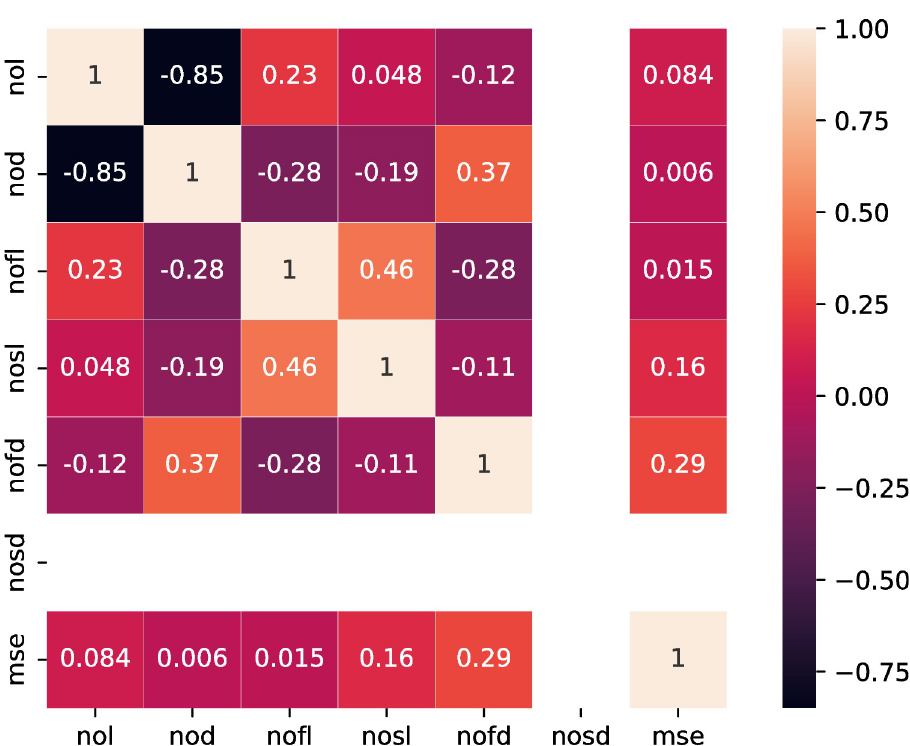
Fig 9. Correlation of 30 optimal combination